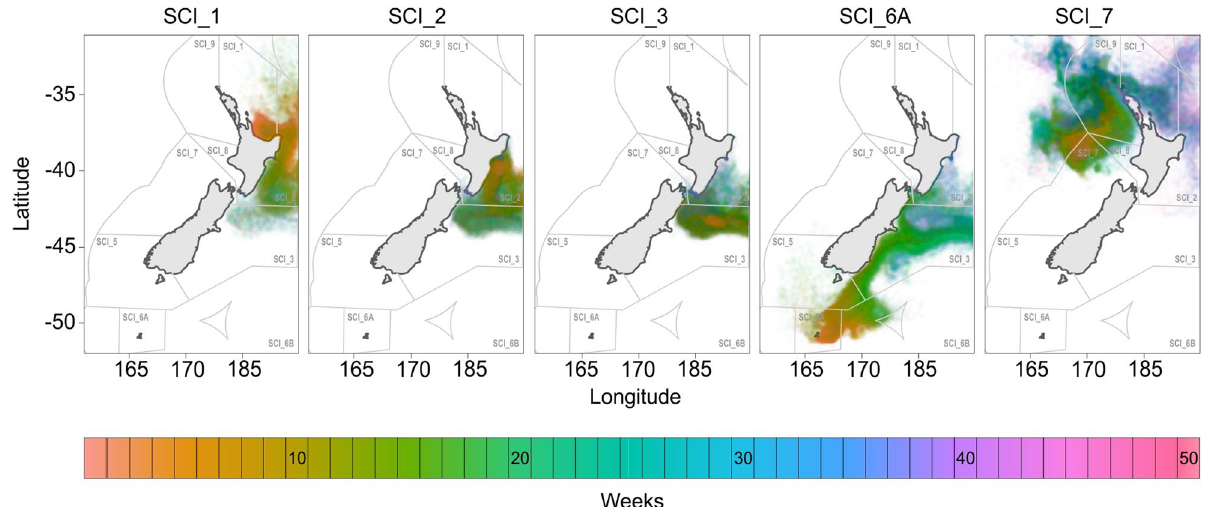
Figure 4. Modelled positions of particles in New Zealand waters recorded weekly up to approximately one year after being released from the five scampi fishery management areas (SCI_1, SCI_2, SCI_3, SCI_6A and SCI_7). Plotted is a random selection of 20,000 particles that were released divided equally per SCI, and their movement captured. The figure’s main elements, i.e., New Zealand and position of particles, were generated with ggplot2 v3.3.3 114 and rnaturalearth v0.1.0 117 . Other aesthetic elements were added using Corel Draw Essentials X5